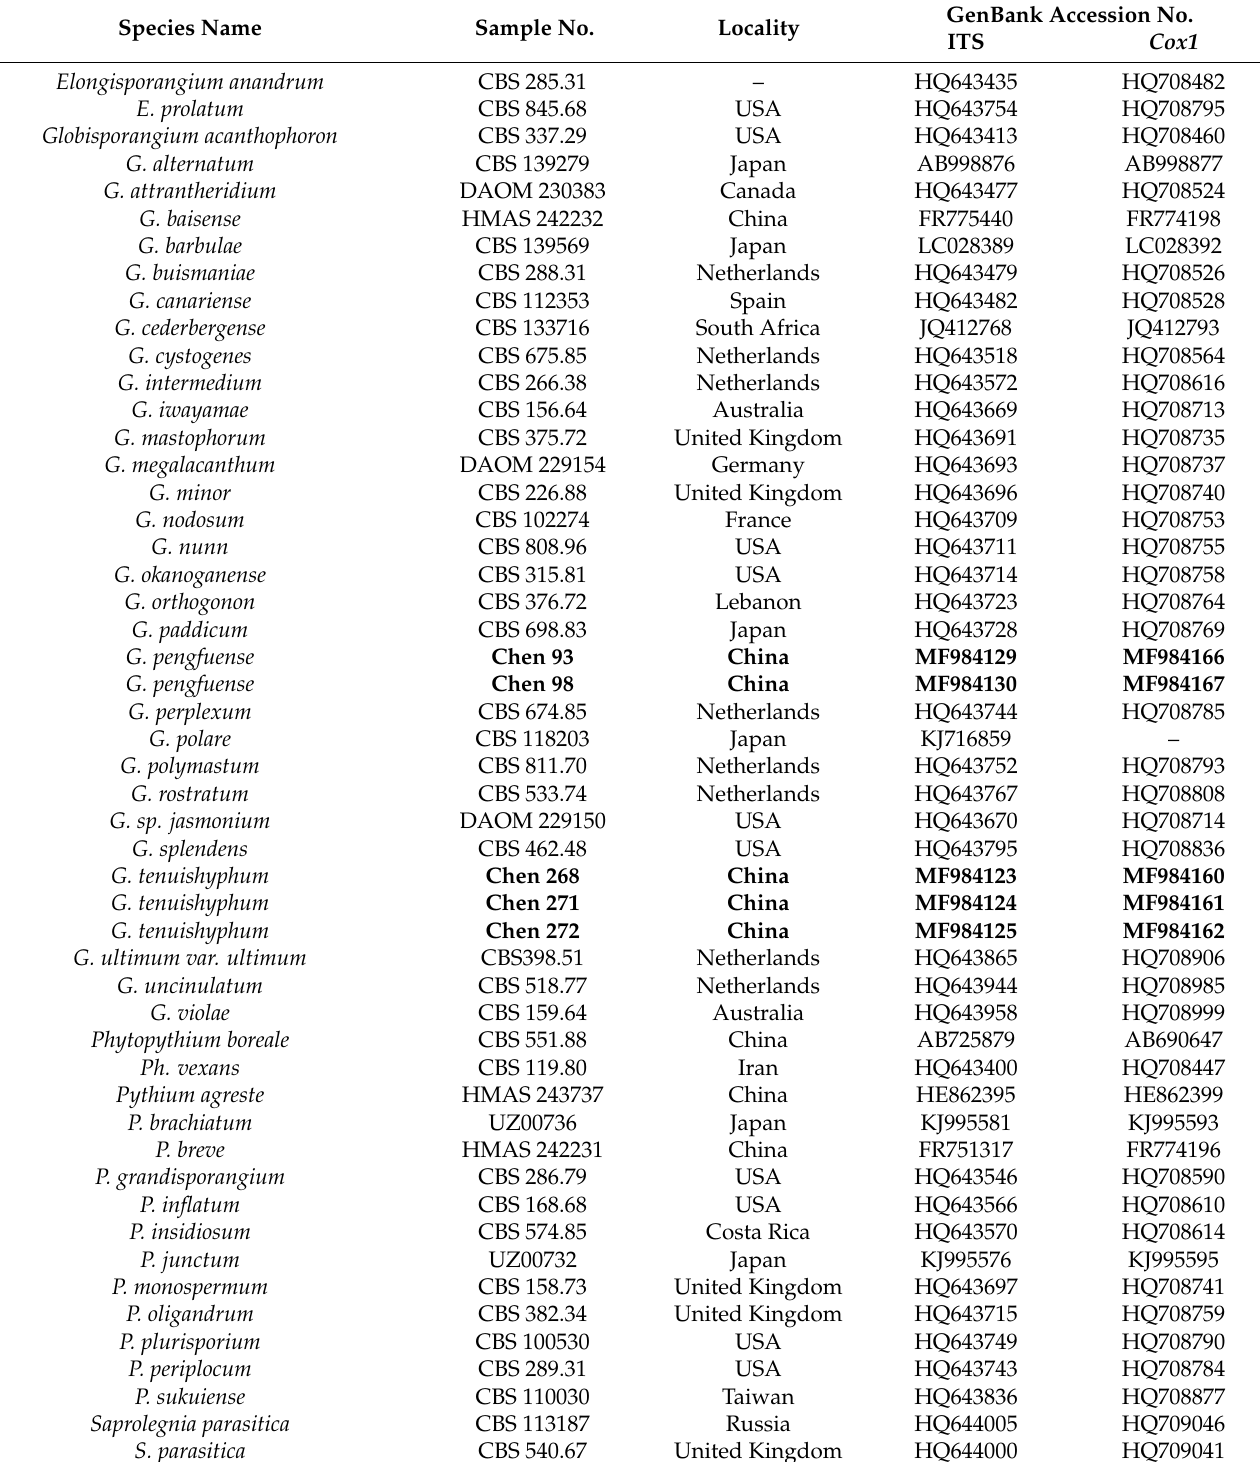
Table 1. A list of species, cultures, and GenBank accession numbers of sequences used in this